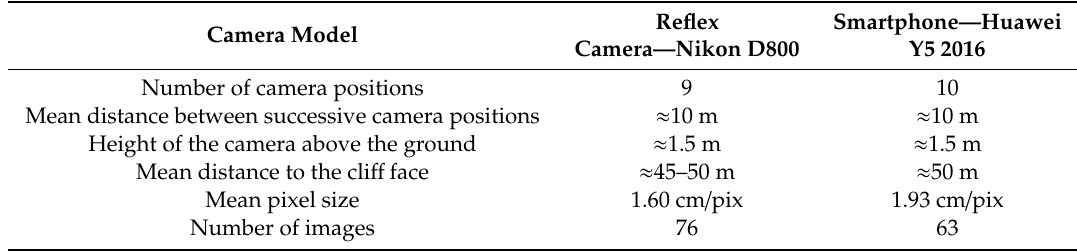
Table 2. Image acquisition carried out with the Nikon D800 reflex camera (test 1) and with the Huawei Y5 Smartphone (test